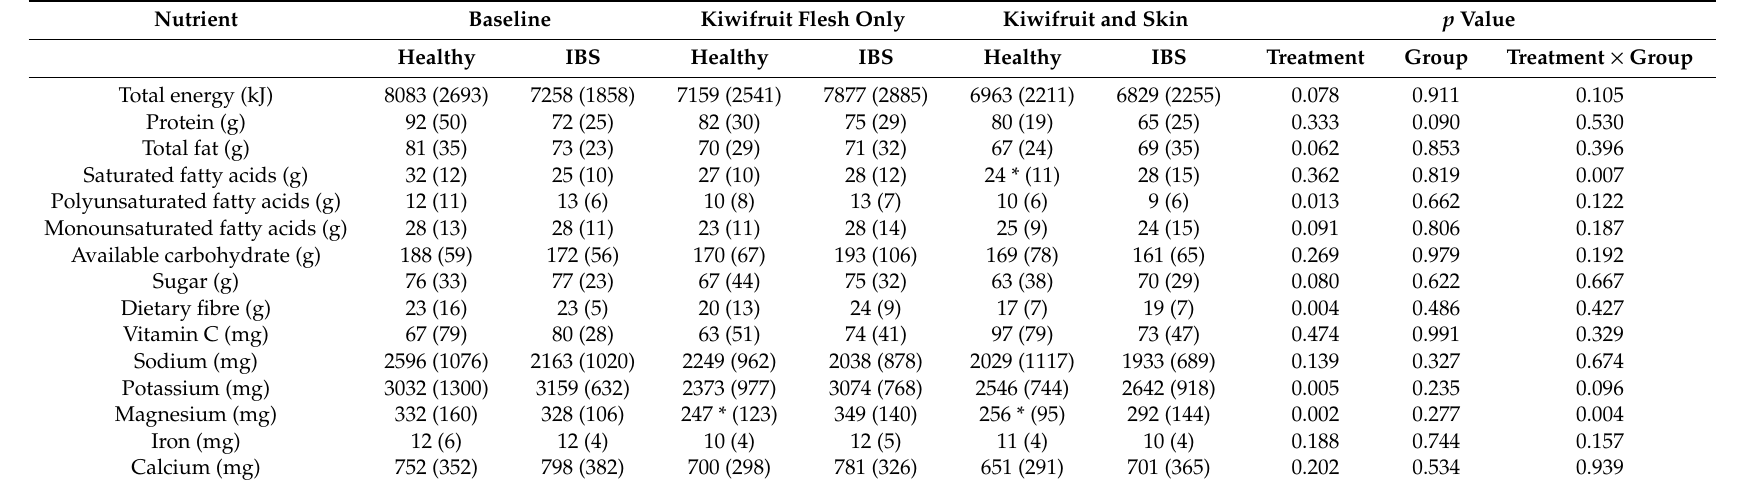
Table 8. Daily dietary intakes of selected nutrients by the participants excluding the Zespri ® SunGold kiwifruit ( Actinidia chinensis var. chinensis ‘Zesy002’) interventions 1